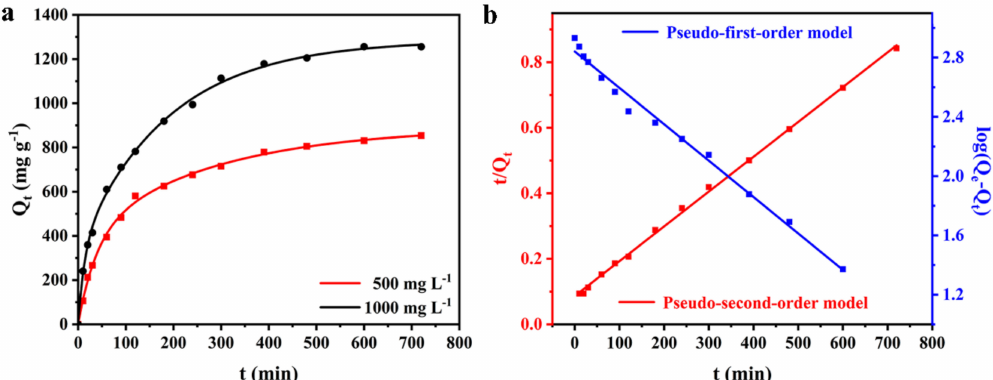
Figure 3. ( a ) The adsorption kinetic of AS for MB removal at initial MB concentrations of 500 and 1000 mg L − 1 ; ( b ) the fitting adsorption data for the pseudo-first-order and the pseudo-second-order kinetic models, C 0 = 500 mg L − 1 .